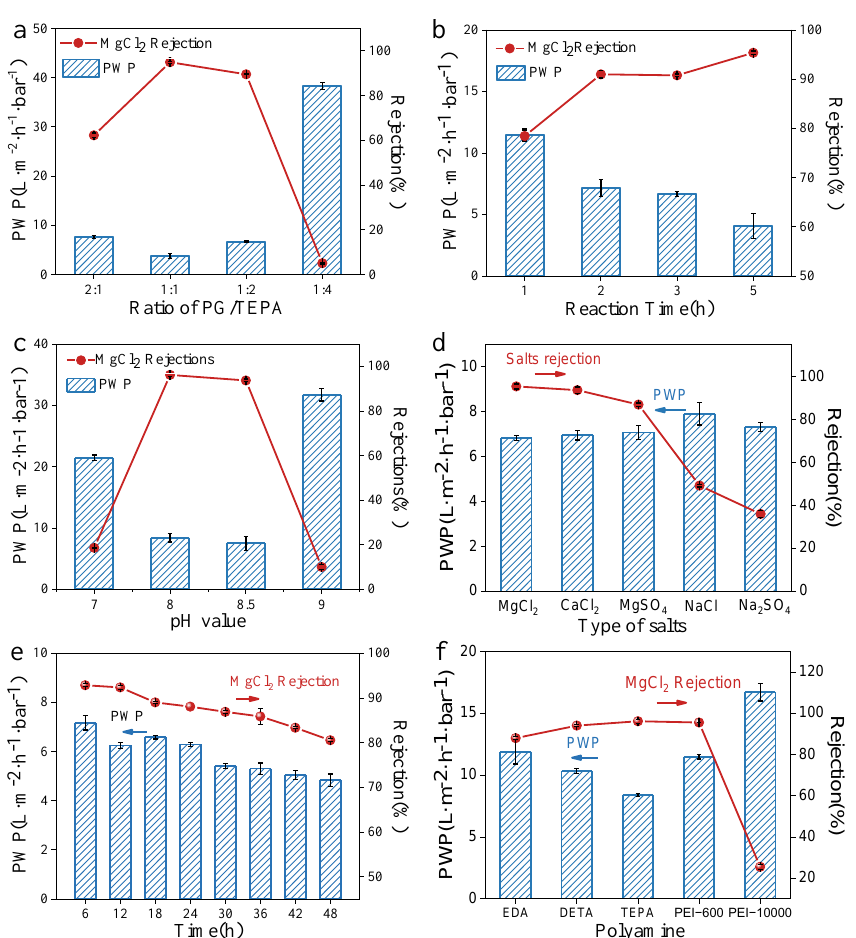
Figure 7. Separation performances of the various PG/TEPA membranes with different ( a ) ratios of PG to TEPA (5 h, pH 8.5), ( b ) reaction times (PG/TEPA = 1:1, pH 8.5), and ( c ) pH values of buffer solutions (PG/TEPA = 1:1, 2 h). ( d ) Ion screening performances of the PG/TEPA membrane (optimal condition: PG/TEPA = 1:1, 2 h, pH 8.0) for different inorganic salt solutions with the concentration of 1000 mg/L. ( e ) Long-term separation performances of the PG/TEPA membrane (optimal condition: PG/TEPA = 1:1, 2 h, pH 8.0) within 48 h. ( f ) Separation performances of the PG/polyamine membranes (optimal condition: PG/polyamines = 1:1, 2 h, pH 8.0), the feeding solution is MgCl 2 solution at a concentration of 1000